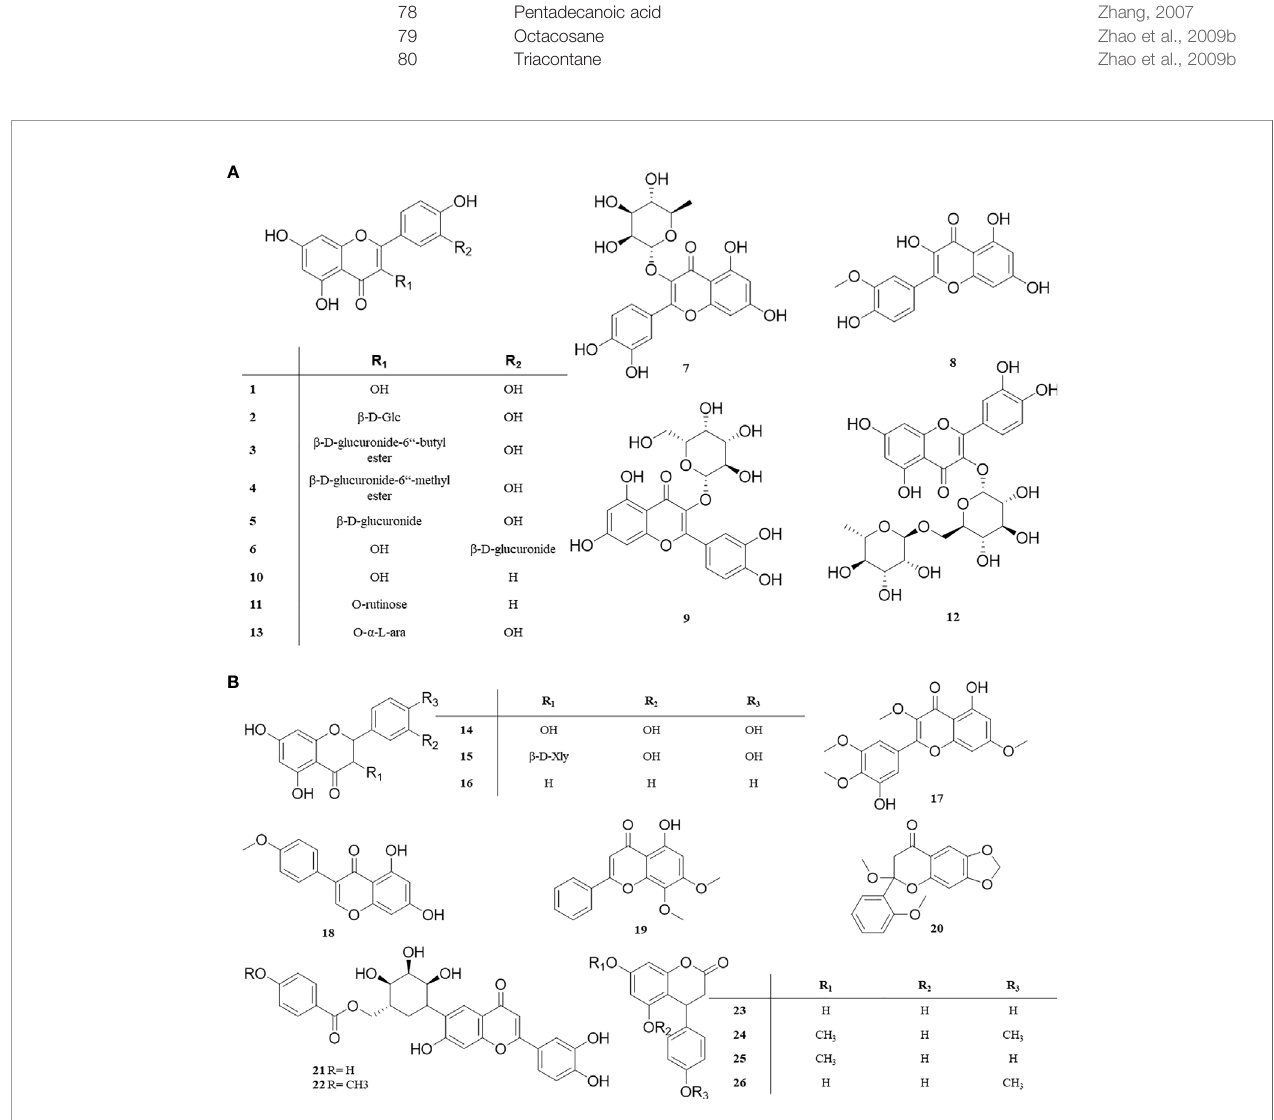
FIGURE 2 | (A, B) Structure of fl avonoids from P.